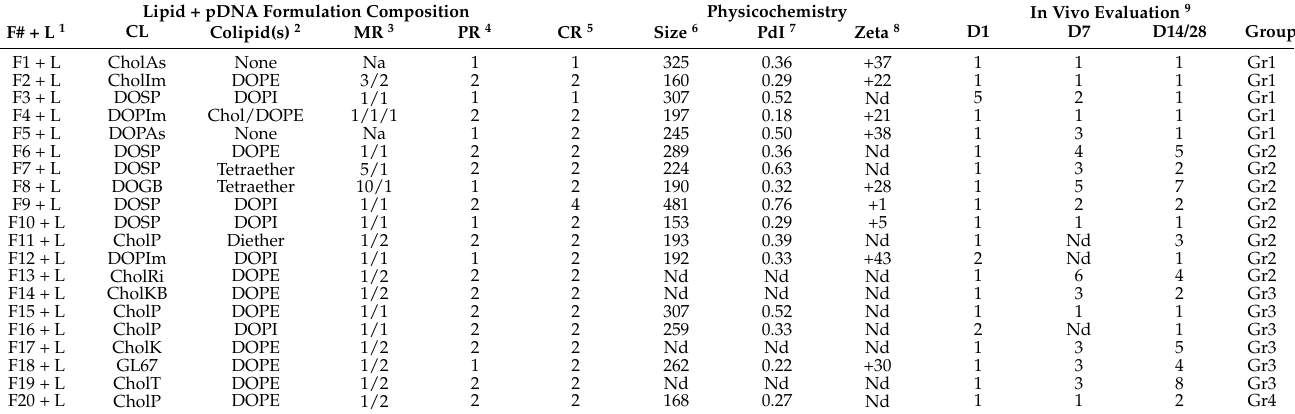
Table 3. Composition, physicochemical characterizations, and in vivo evaluation of